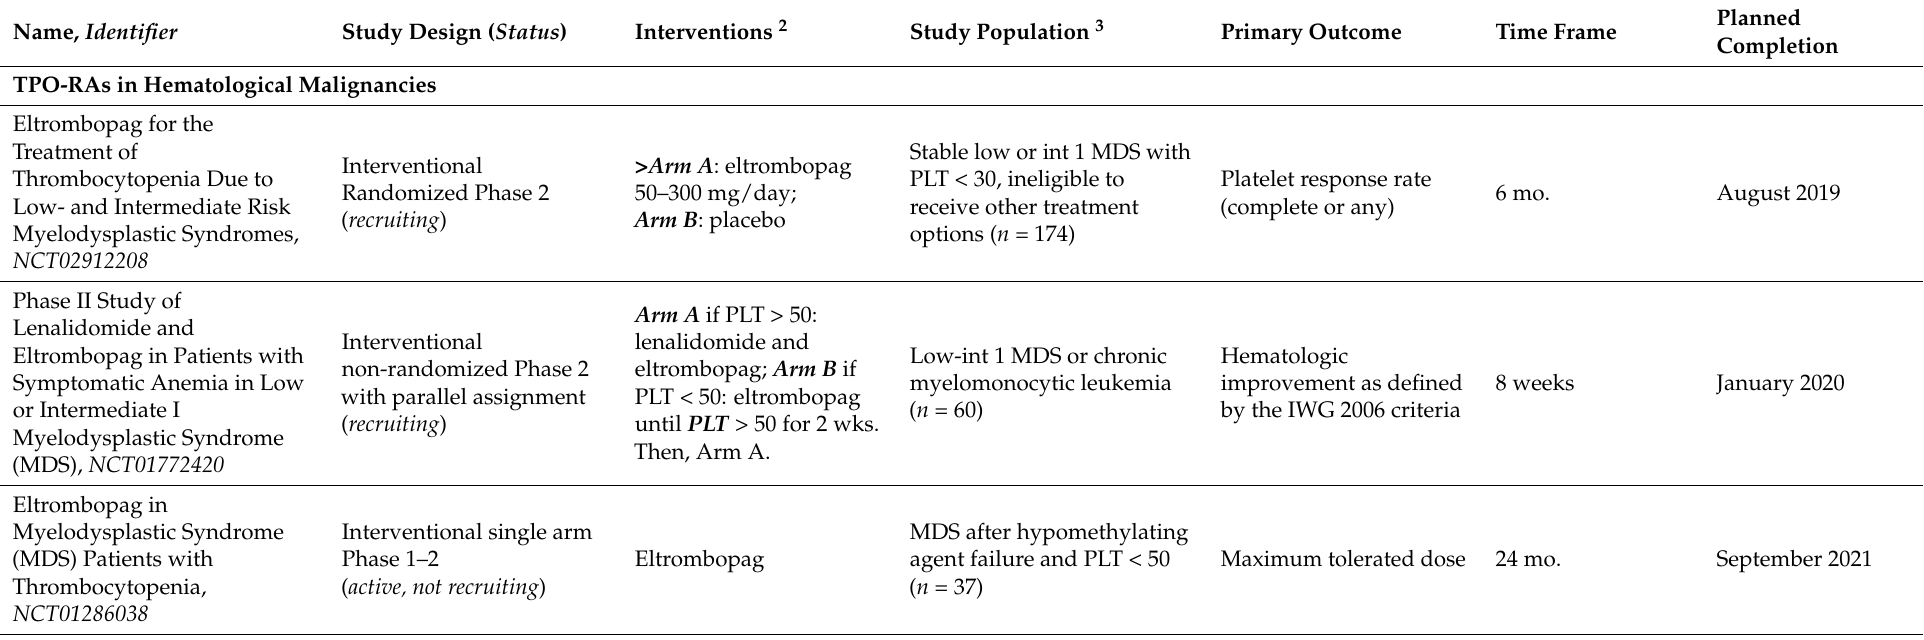
Table 4. Ongoing and planned clinical trials of TPO-RAs in thrombocytopenia and cancer 1